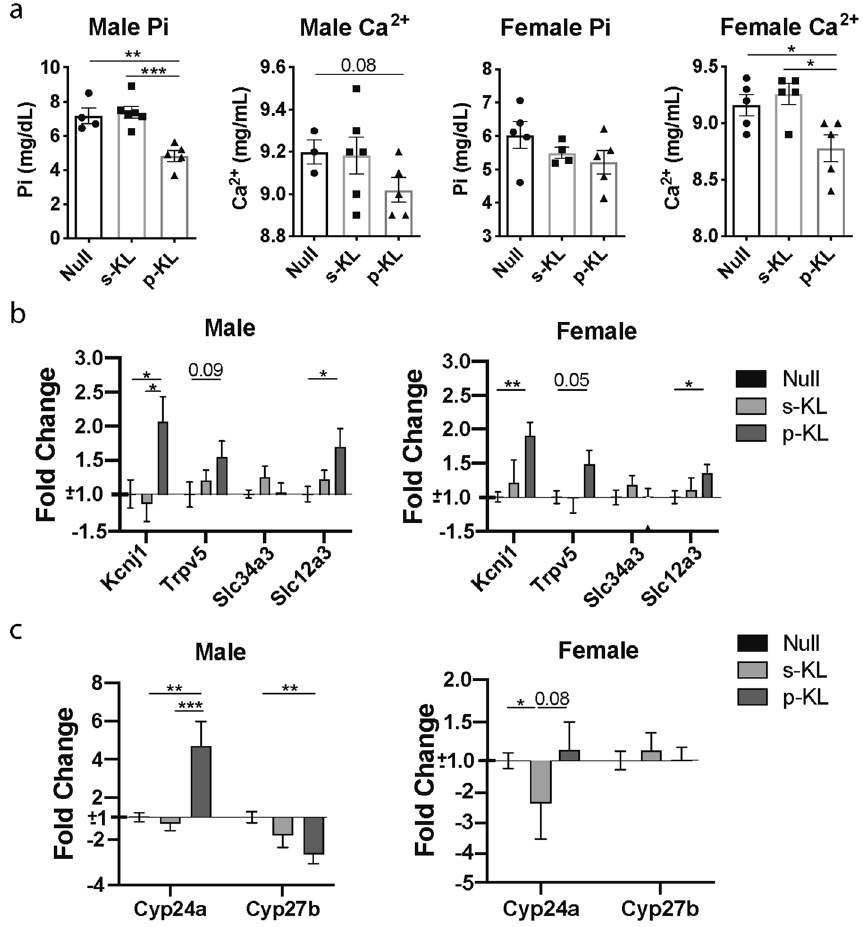
Figure 2. ( a ) Ca 2+ and Pi serum levels after 8 weeks of treatment. ( b ) Expression of ion channels in kidney. ( c ) Expression of genes involved in vitamin 1,25D activation and degradation. Data are presented as fold change expression compared to Null-treated animals. Mean ± Standard error of the mean (SEM) for ( a ), and relative quantity (RQ) ± standard error of RQ for ( b,c ); n = 4–6; *p < 0.05; **p < 0.01; ***p < 0.001 for differences between the treatment